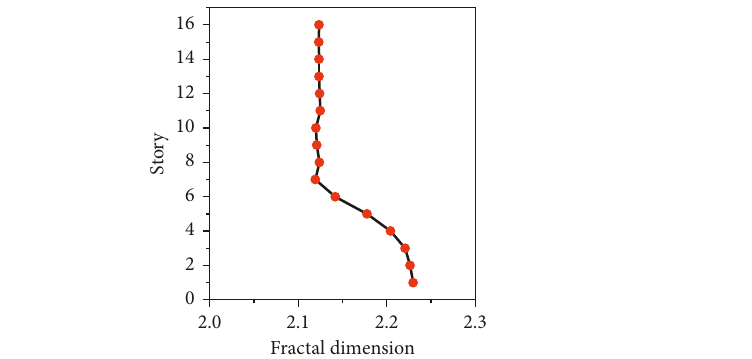
715gal El Centro ground motion (Case 5). (cid:29)